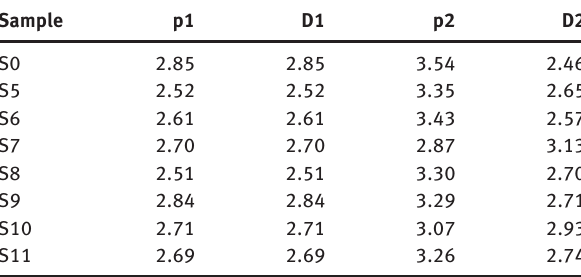
Table 3: Fitted parameters (p1 and p2 are exponents of the two different fractal regions; D1 and D2 are the corresponding fractal